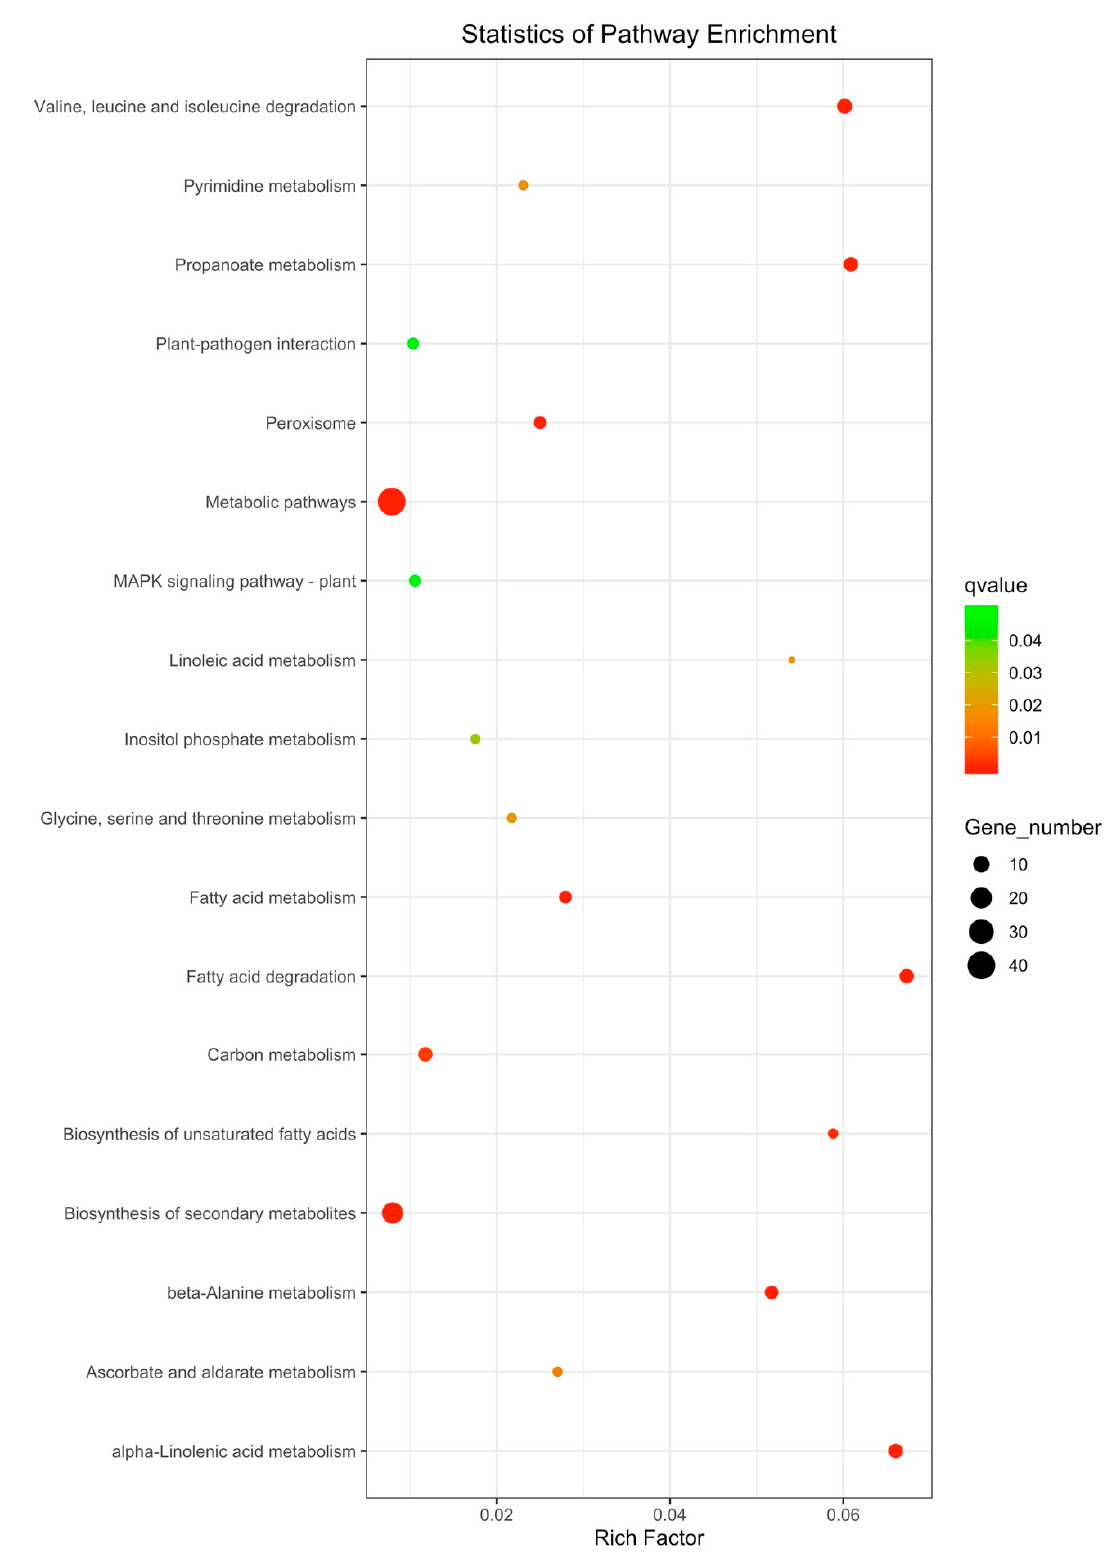
Figure 5. KEGG pathways enriched for up-regulated DEGs in K 326 Wz/Wz inoculated with the Wz -H isolate of P. nicotianae compared to inoculated Hicks. The y -axis indicates the name of the KEGG pathway. The dot size means the gene number. The dot color indicates the q -value.